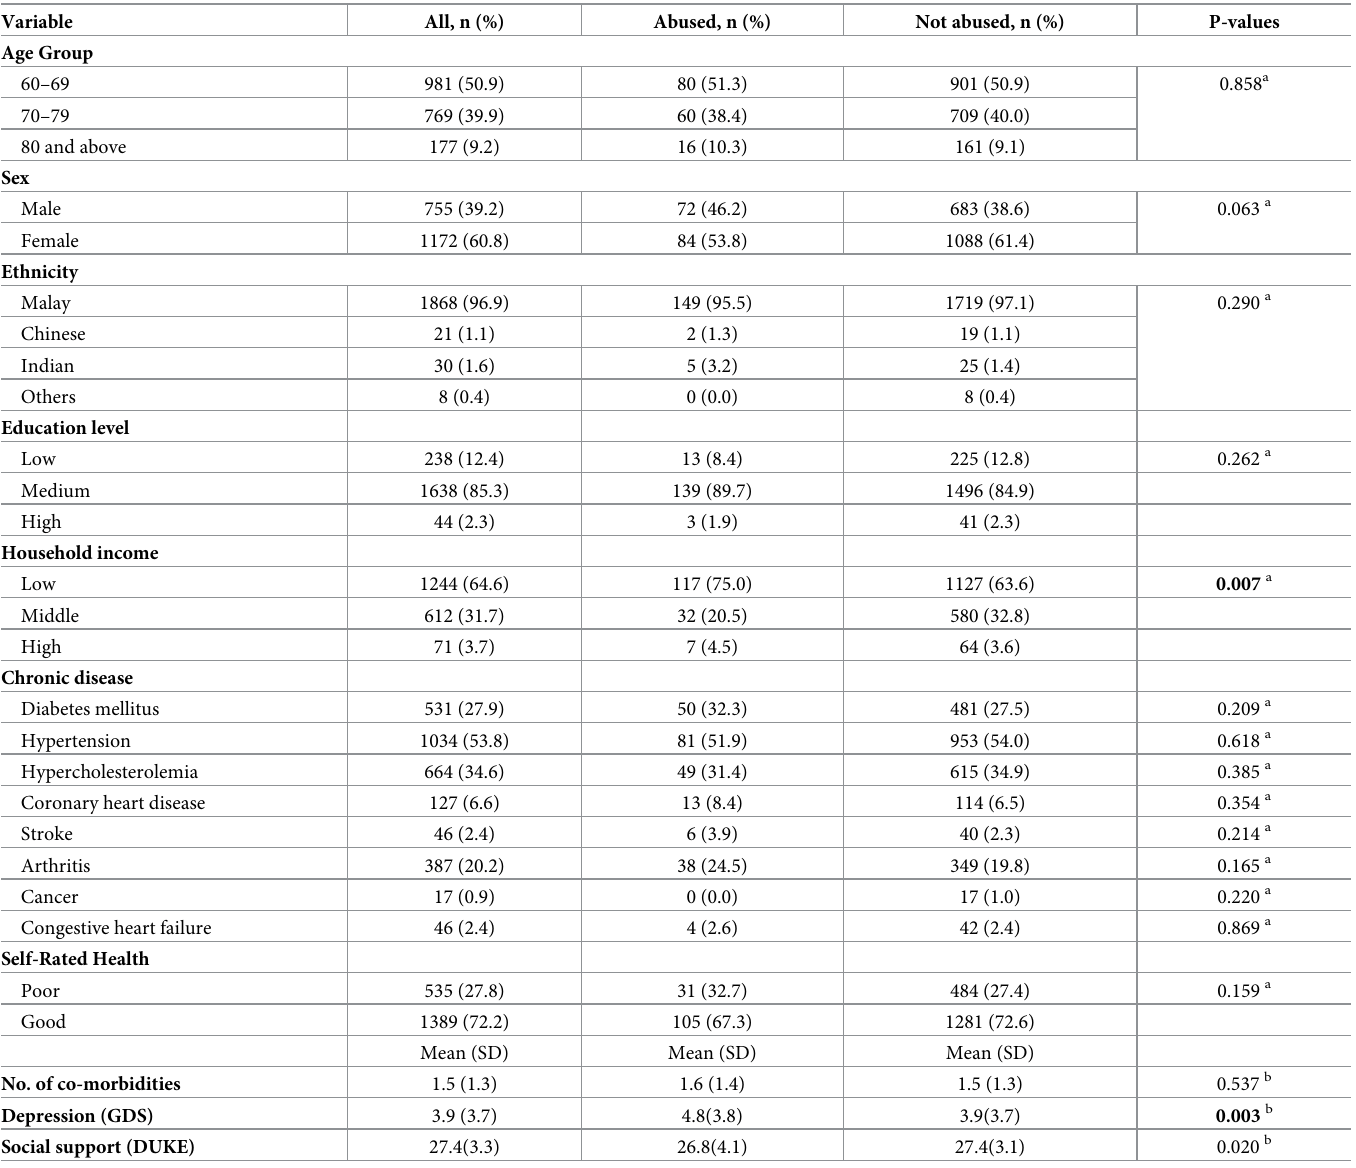
Table 1. Basic characteristics of study participants (N =